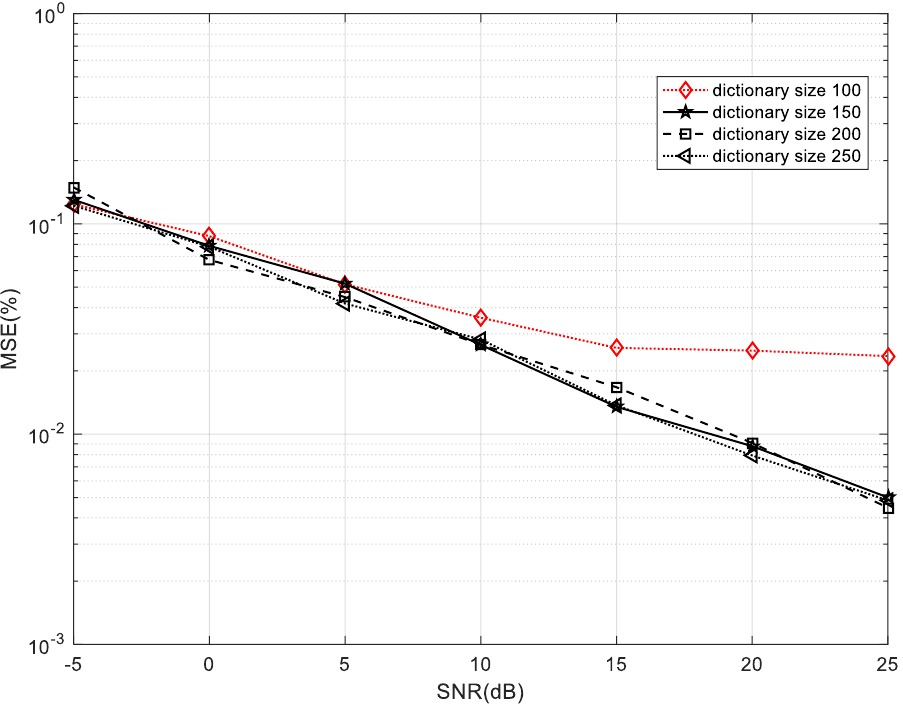
Figure 6. Comparisons of channel estimation of MSE for the proposed algorithm with different dictionary sizes.